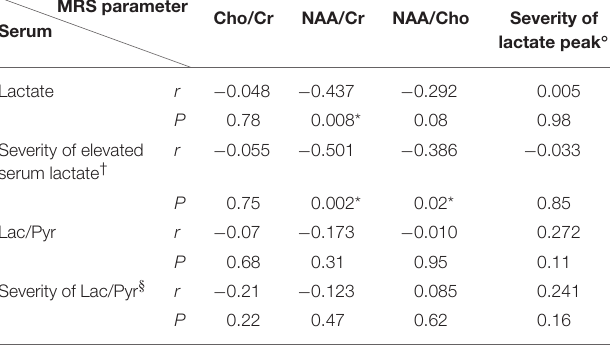
TABLE 5 | Correlation of serum biomarkers and magnetic resonance spectroscopy (MRS) parameters in normal regions ( n = 36). MRS parameter Serum